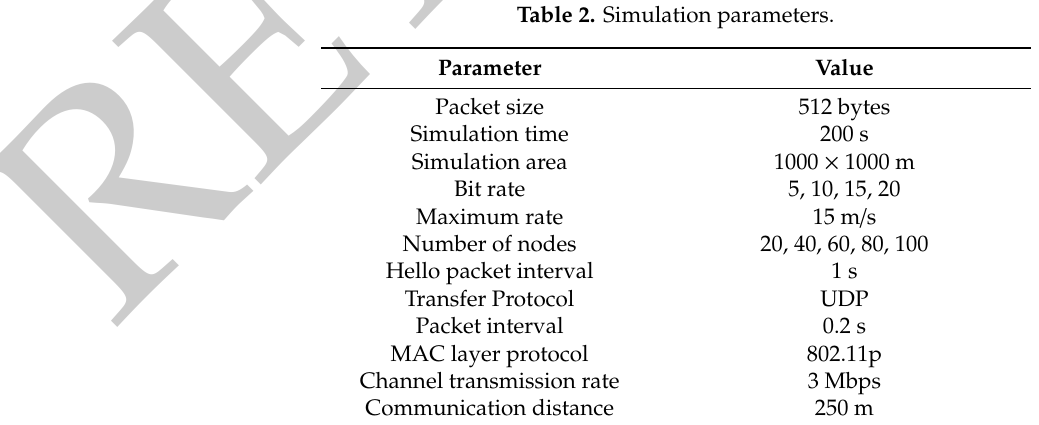
Table 2. Simulation parameters.